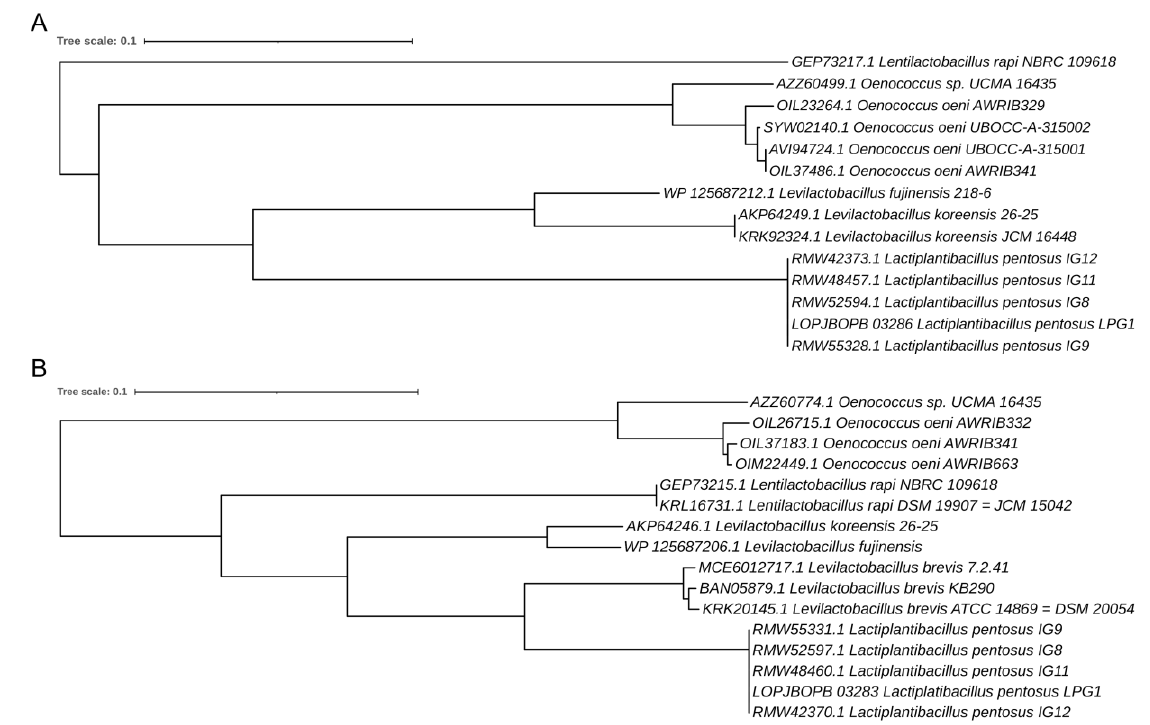
Figure 6. Phylogenetic analysis performed by the neighbor-joining method with 1000 replications in the bootstrap test. ( A ) Tree based on the L-arabinofuranosidase gene. ( B ) Tree based on the beta-galactosidase gene.